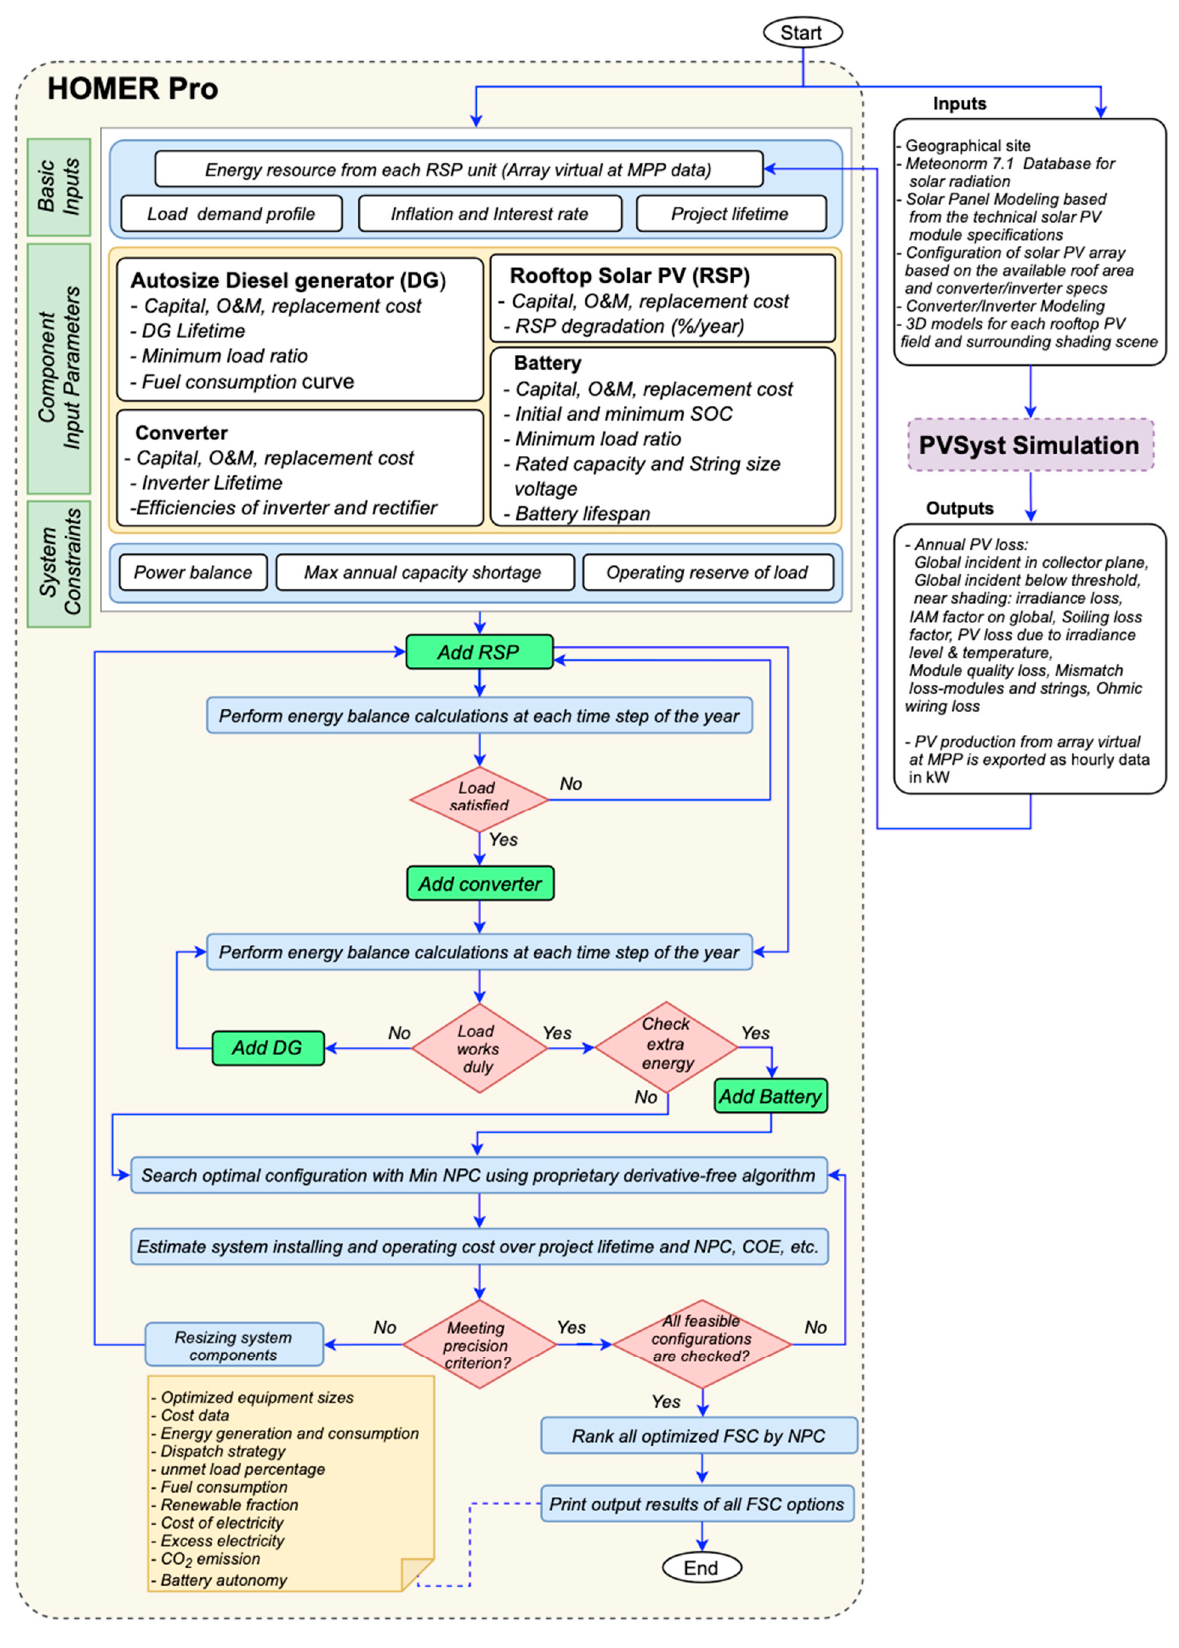
Figure 9. Procedure for the selection of all feasible system configurations (FSCs) using PVSyst and HOMER Pro.